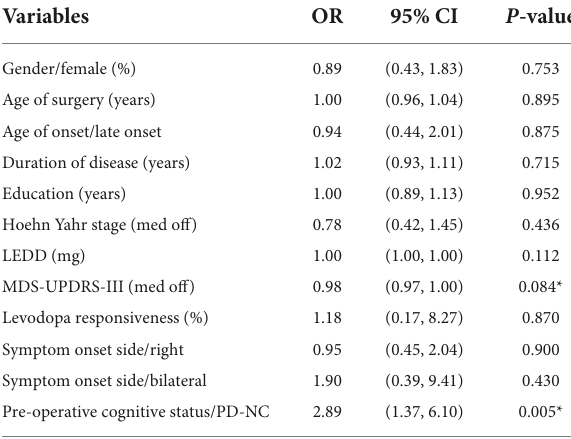
TABLE 4 Impact of pre-operative cognitive status, clinical and demographic data on post-operative cognitive decline (univariate logistic regression